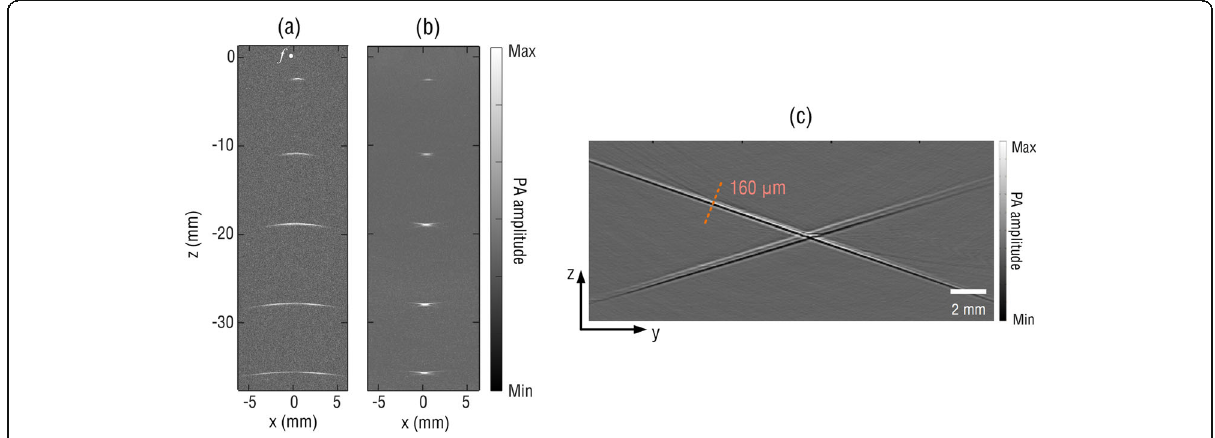
Fig. 5 Measured ( a ) B-scan and SAFT ( b ) images, and image of a hair cross on the y-z plane ( c